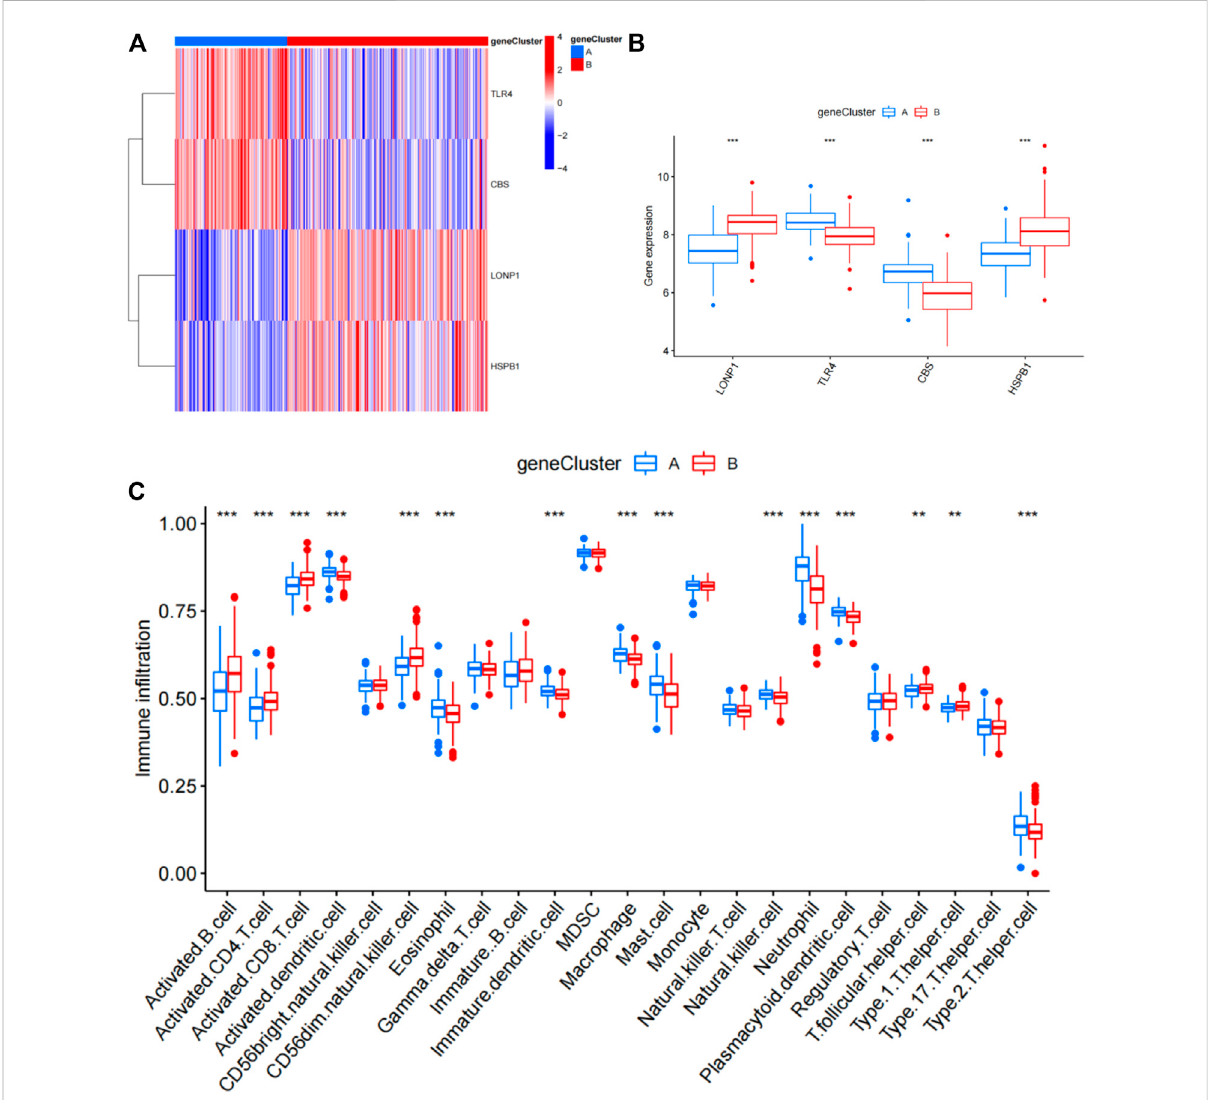
FIGURE 10 Differential analysis of four subgroup-speci fi c genes and in fi ltrating immune cells between gene cluster A and gene cluster B. (A) Expression heat map of the four subgroup-speci fi c genes in gene cluster A and gene cluster B. Red: gene cluster B; blue: gene cluster A; red: high expression; blue: low expression. (B) Differential expression histogram of the four subgroup-speci fi c genes in gene cluster A and gene cluster B. Red: gene cluster B; blue: gene cluster A. (C) Differential immune cell in fi ltration between gene cluster A and gene cluster B. Red: gene cluster B; blue: gene cluster